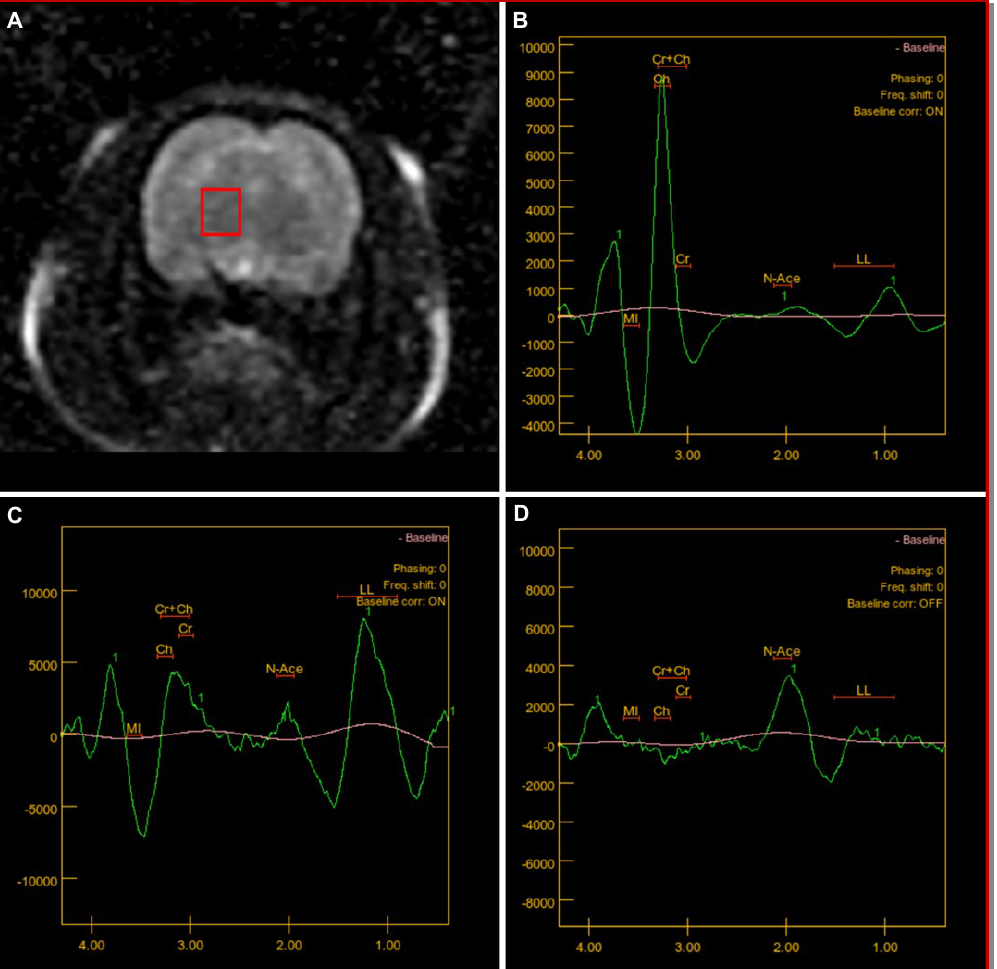
Figure 4: MR spectroscopy . A: MR spectroscopy chosen area (Red box), B: Normal Control Group male Rats, C: PA and saline group male rats, D: PA and MA group male